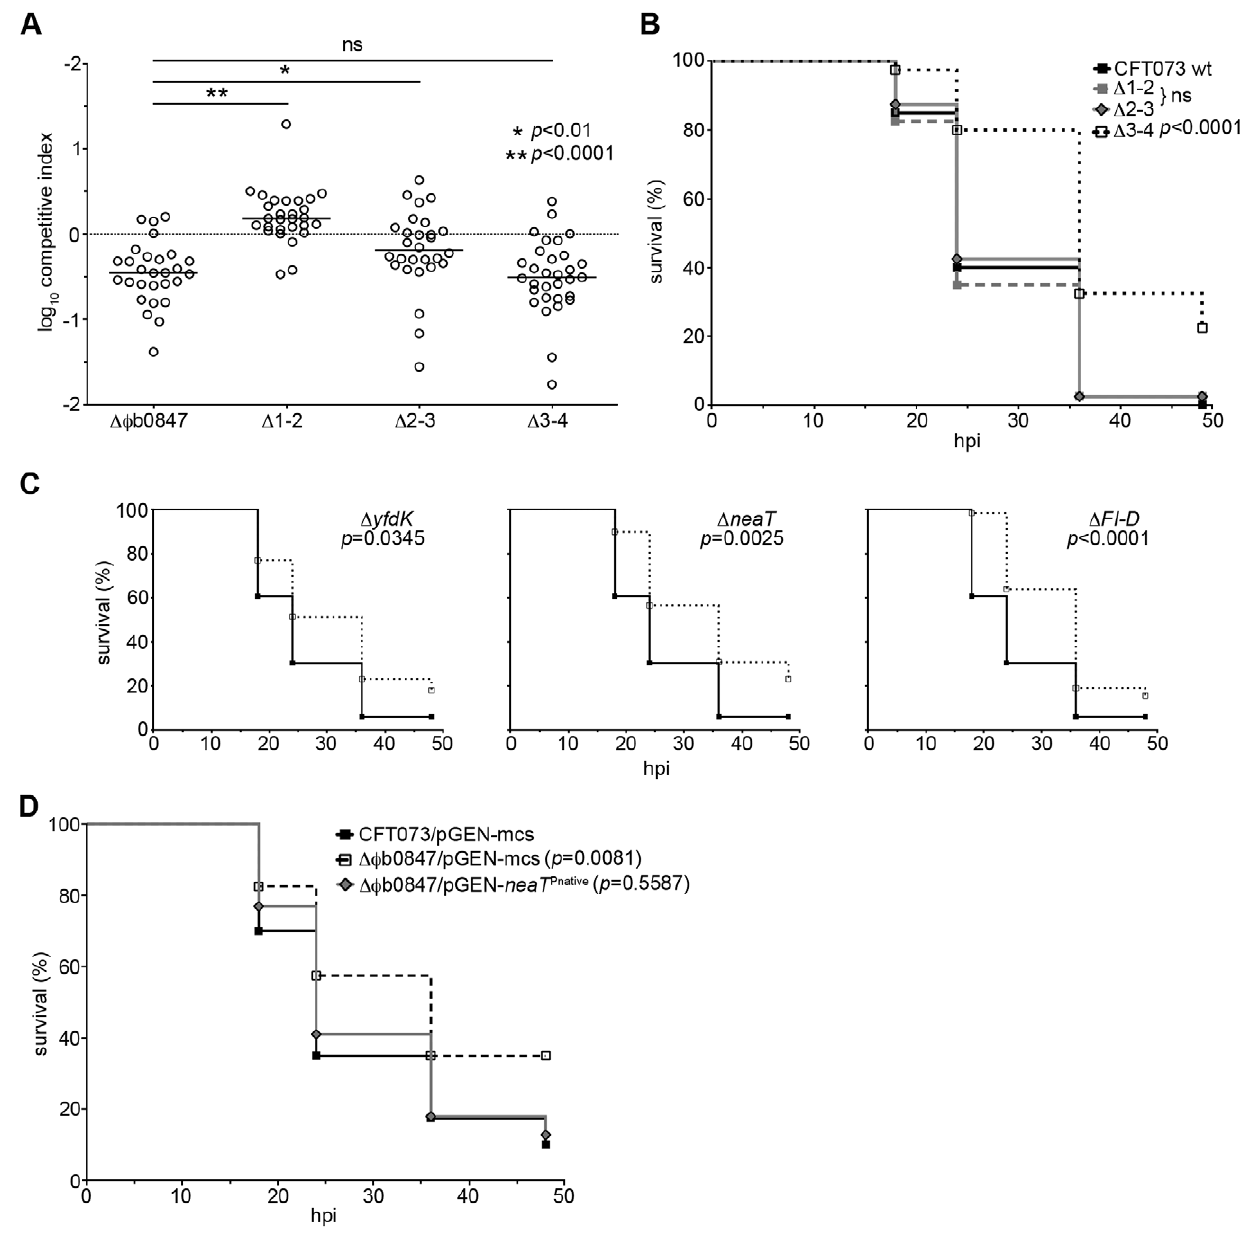
Figure 3. w b0847 harbors multiple loci that contribute to the fitness of CFT073 during systemic challenge. (A) Equal numbers (1,000– 2,000 CFU total) of wild type CFT073 and each mutant derivative indicated were inoculated into the bloodstream of embryos. Fish were sacrificed and bacterial loads enumerated at 12 hours post inoculation (hpi) by differential plating ( n . 28). Data are presented as competitive indices with negative values indicating a reduction in fitness of the mutant. P values were determined using two-tailed Mann-Whitney t tests; bars indicate median values. (B), (C), and (D) 1,000–2,000 CFU of wild type CFT073, the indicated mutant, or recombinant derivative were each inoculated into the blood of 48 hpf embryos. Fish were scored for death every 6 h starting at 18 hpi until 48 hpi ( n =40 or more embryos for each curve). pGEN-mcs in (D) serves as an empty vector control for pGEN- neaT Pnative . Data in (B), (C), and (D) are presented as Kaplan-Meier survival plots. A log-rank (Mantel- Cox) test was used to determine p values; ns=not